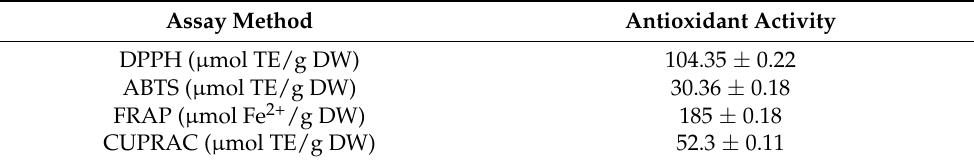
Table 1. Antioxidant capacity of S. nigra L. measured by different complementary